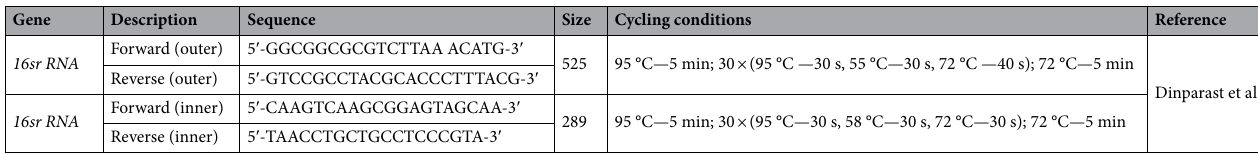
Table 5. Primer sequences and thermal conditions used for molecular detection of leptospira spp sheep and goates urine